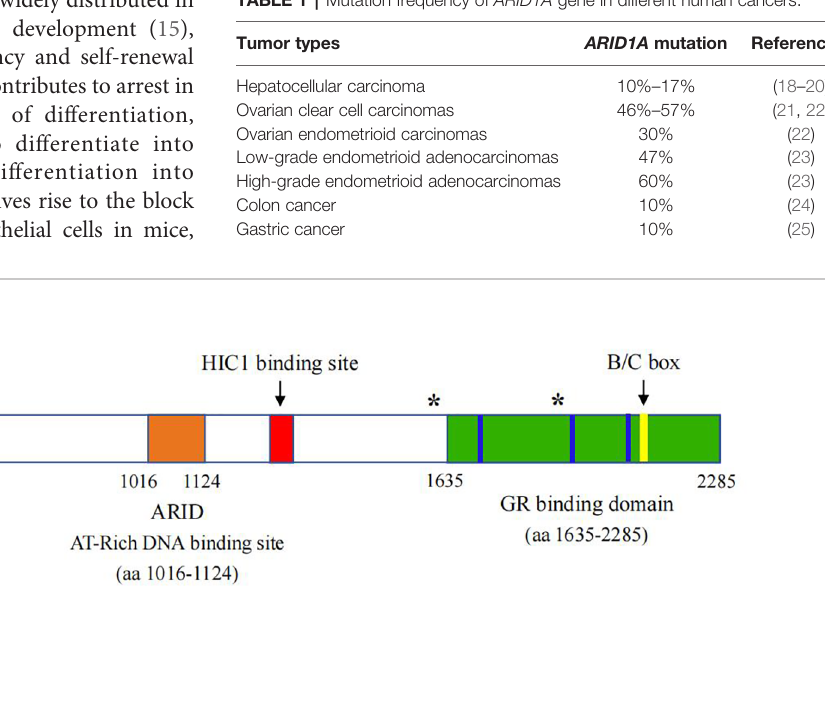
TABLE 1 | Mutation frequency of ARID1A gene in different human